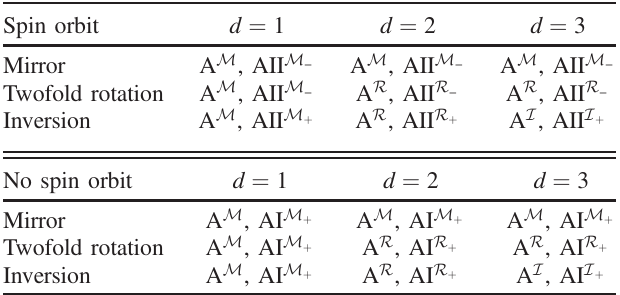
TABLE VIII. Shiozaki-Sato classes that correspond to natural physical realizations of the order-two symmetries for insulators. The top and bottom panels are for crystals with and without strong spin-orbit coupling, respectively. Time-reversal-symmetric insulators have tenfold-way class AII or AI, otherwise the class is A.